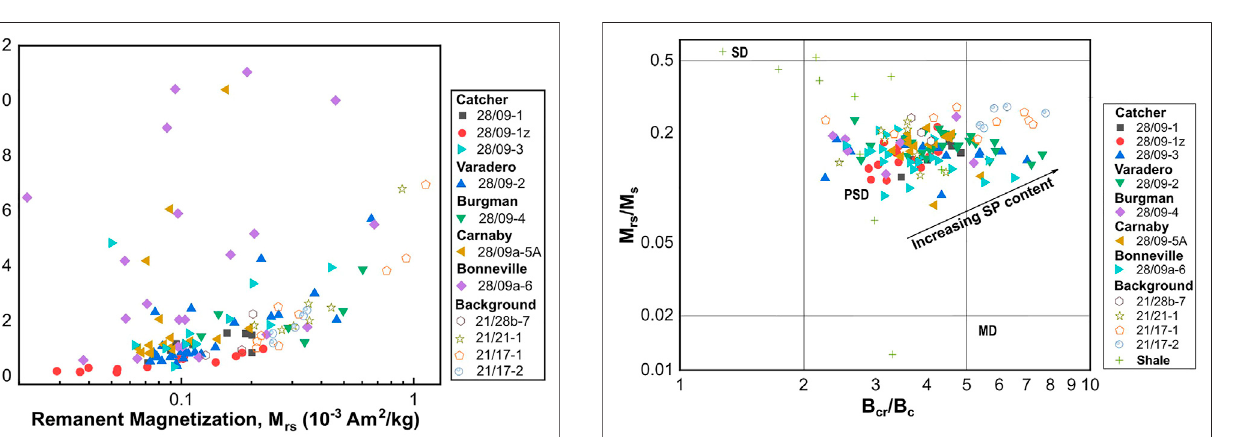
FIGURE 4 | Relationship between remanent magnetization and magnetic susceptibility for CAD hydrocarbon reservoir sandstones (solid symbols) and the background sandstones (hollow symbols). For the background samples, there exists a strong correlation between M rs and χ with R-squared value of 0.89. However, the correlation for these two parameters is weak for the CAD samples (R-squared value of ~0.2). These R-squared values are statistically signi fi cant with p -values of < 0.05.